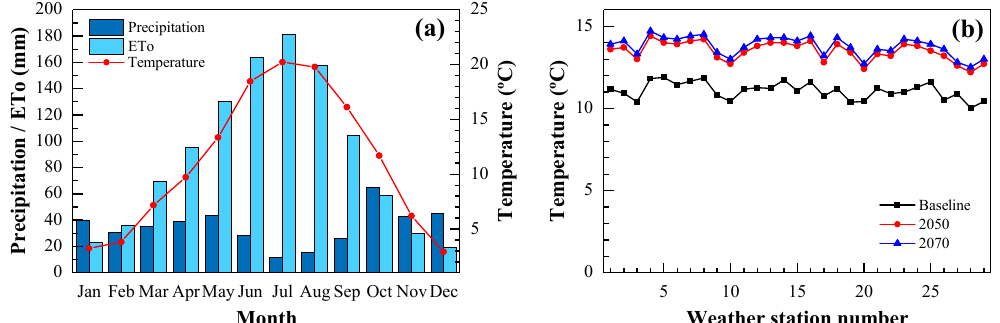
Figure 2. ( a ) Average monthly precipitation, ET 0 and temperatures, from daily data collected from the 29 weather stations, from 2001 to 2014 (baseline scenario). ( b ) Annual mean temperature at the 29 weather stations. Baseline data (in black) corresponds to mean observed values from 2001 to 2014. Annual mean temperatures in 2050 (in red) and in 2070 (in blue) for the location of each station, obtained from WorldClim, are also shown.